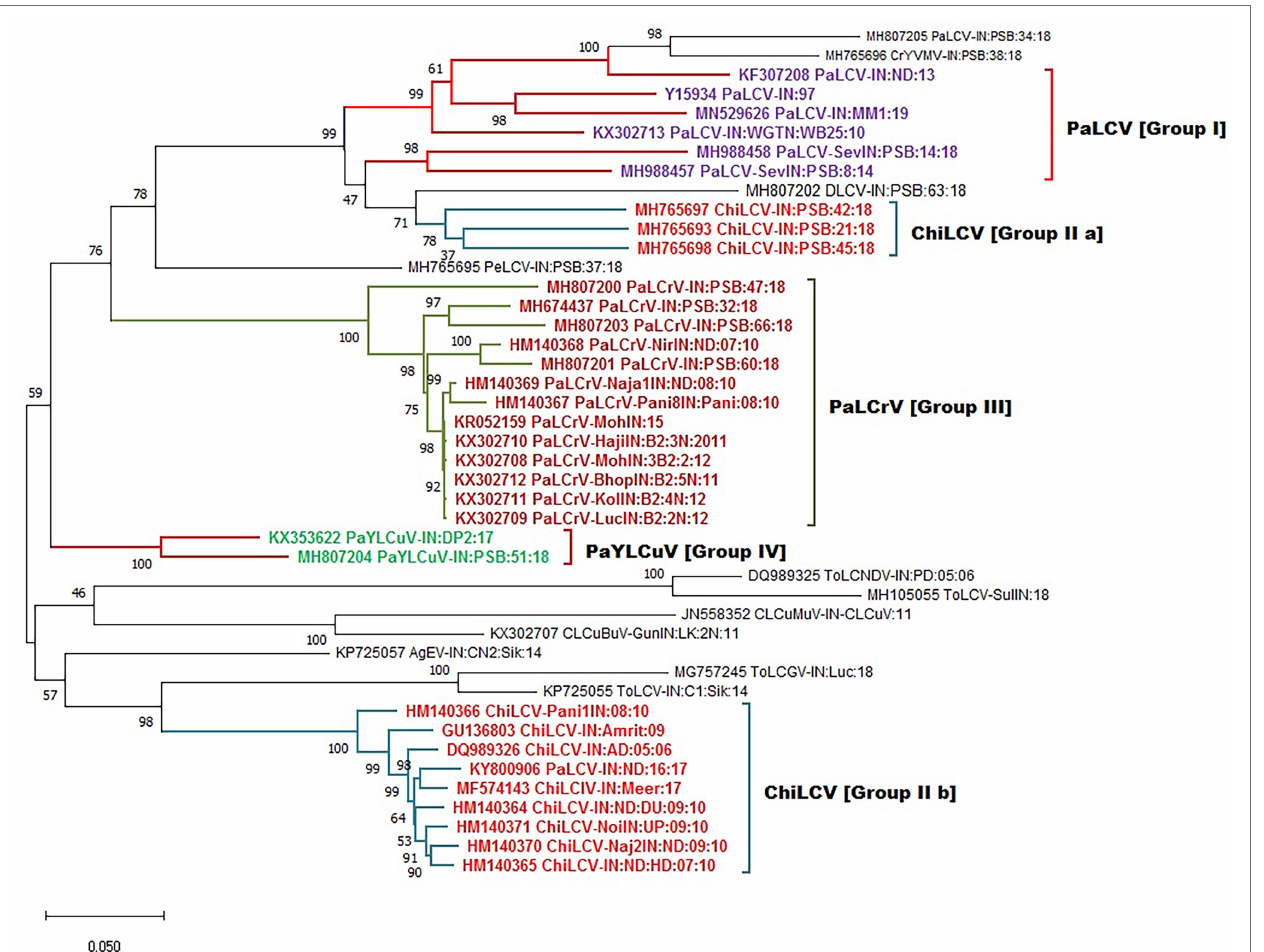
FIGURE 6 | Maximum-likelihood phylogeny-based partitioning tree associated with PaLCD begomoviruses in India aligned using CLUSTAL W with a 1,000 bootstrap value within the MEGA v.10 program; 44 begomovirus isolates (DNA-A sequences) form four distinct major